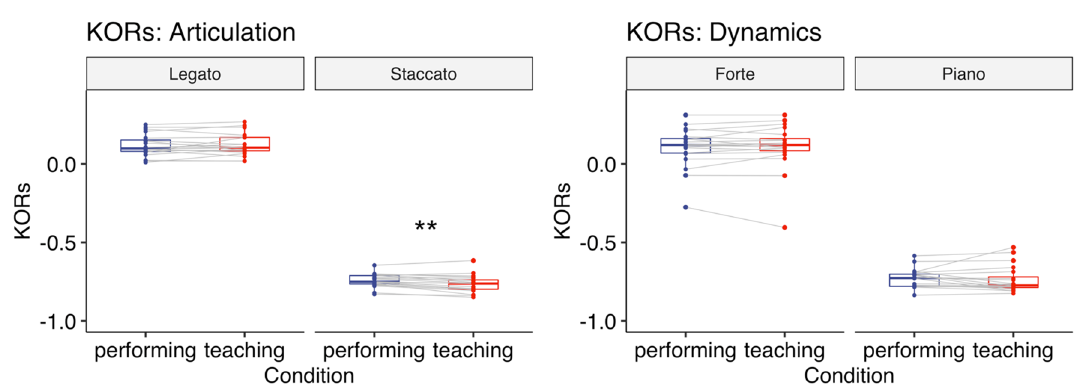
Figure 7. Experiment 2: KORs when playing the piece with either articulation (left) or dynamics (right). Each box indicates the IQR with the median, and whiskers extend to a maximum of 1.5 × IQR beyond the box. Significance levels: * < 0.05, ** < 0.01, *** <